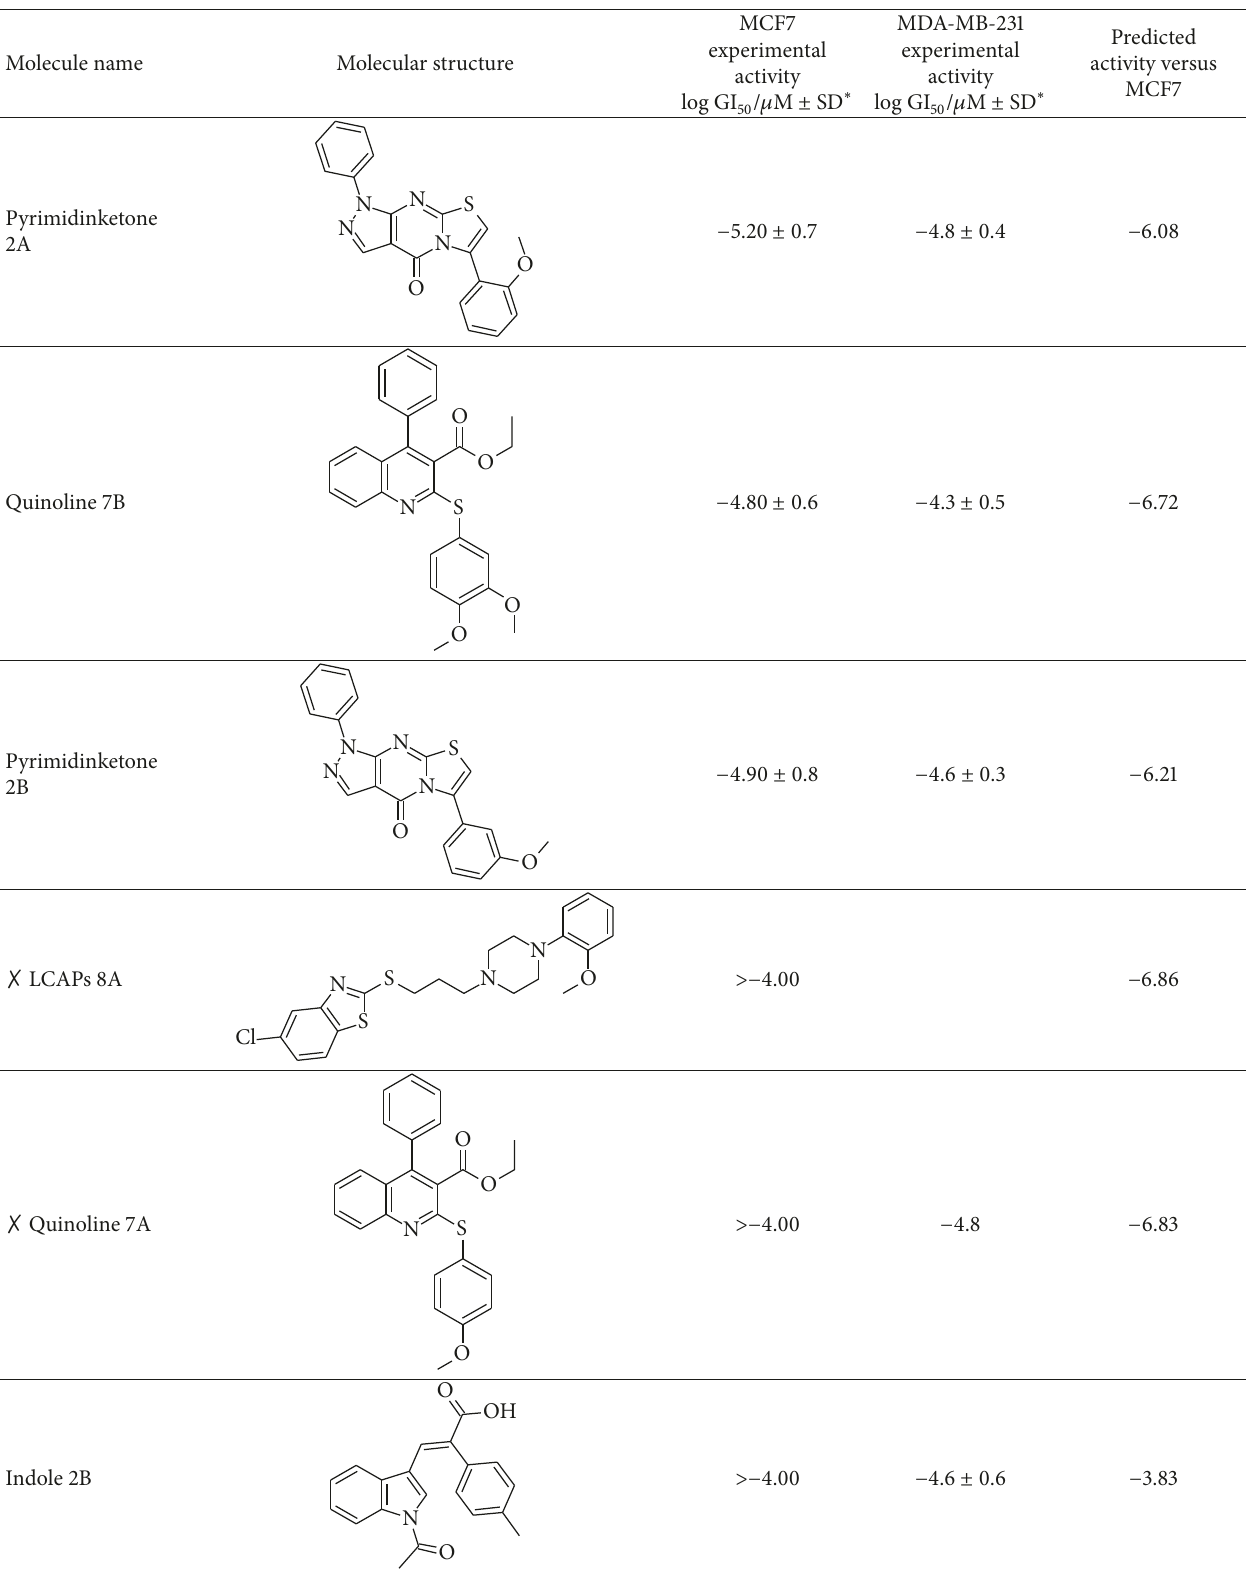
Table 1: Molecular structures, in vitro activity on MCF-7 and MDA-MB-231 cell lines, and in silico activity values for the ten selected compounds and 5-FU. Activity values expressed as log GI 50